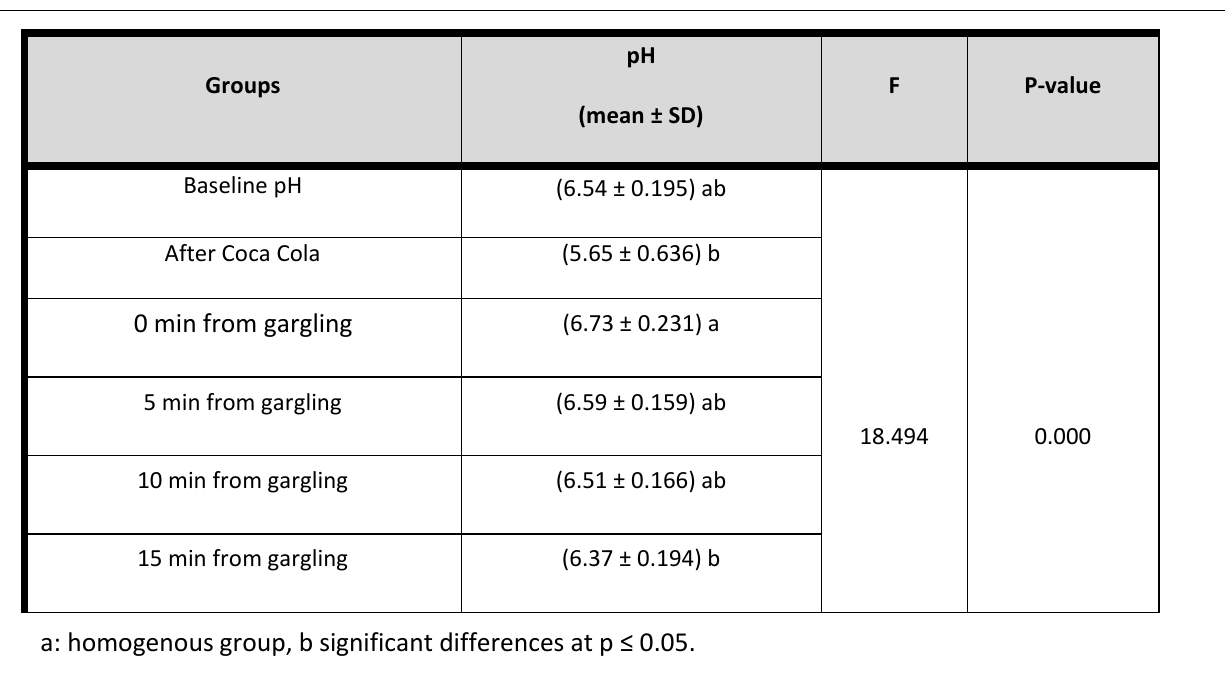
Table 3. One way ANOVA of salivary pH after chlorohexidine mouthwash